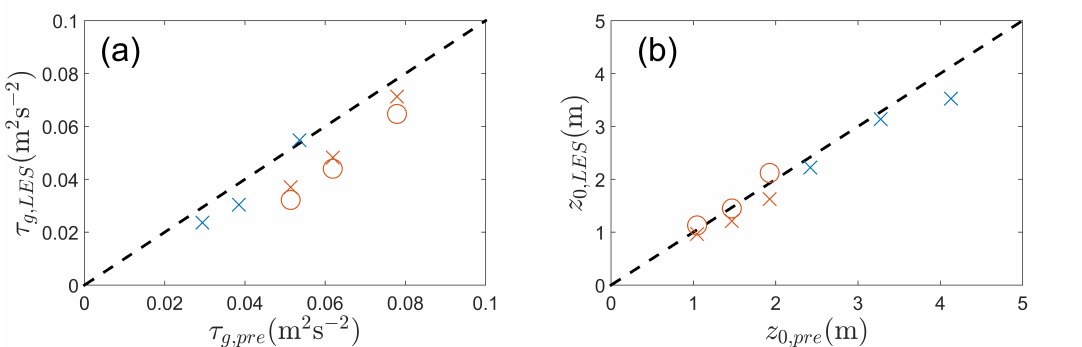
Figure 7. ( a ) Predicted versus simulated aerodynamic properties for an infinite wind farm: surface shear stress; ( b ) Aerodynamic roughness length. Blue markers indicate S x = 6, and red markers indicate S x = 10; × s indicate an aligned arrangement, and circles indicate staggered.